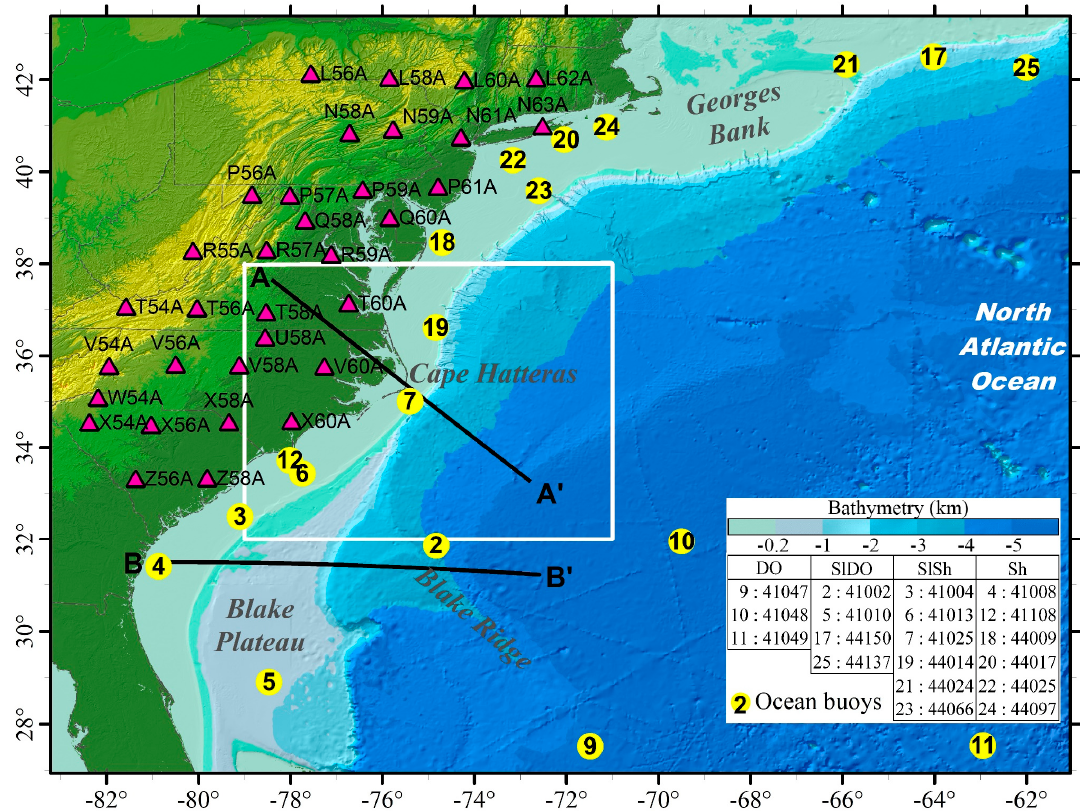
Figure 1. Study area and locations of transportable array (TA) stations (triangles) and buoys (yellow circles) of National Oceanic and Atmospheric Administration, recordings of which are analyzed in this study. The table lists the original numbers and a simplified numbering scheme of the ocean buoys grouped according to their four distinct locations: deep ocean (DO), the continental slope-deep ocean side (SlDO), the continental slope-shelf side (SlSh), and the continental shelf (Sh). The color-encoded relief base map is from [49]. The black lines A-A’ and B-B’ are the transects presented in Figure 9a,b. The white box indicates the area where the underground shear velocity model (Figure 9c,d) was computed based on [15].